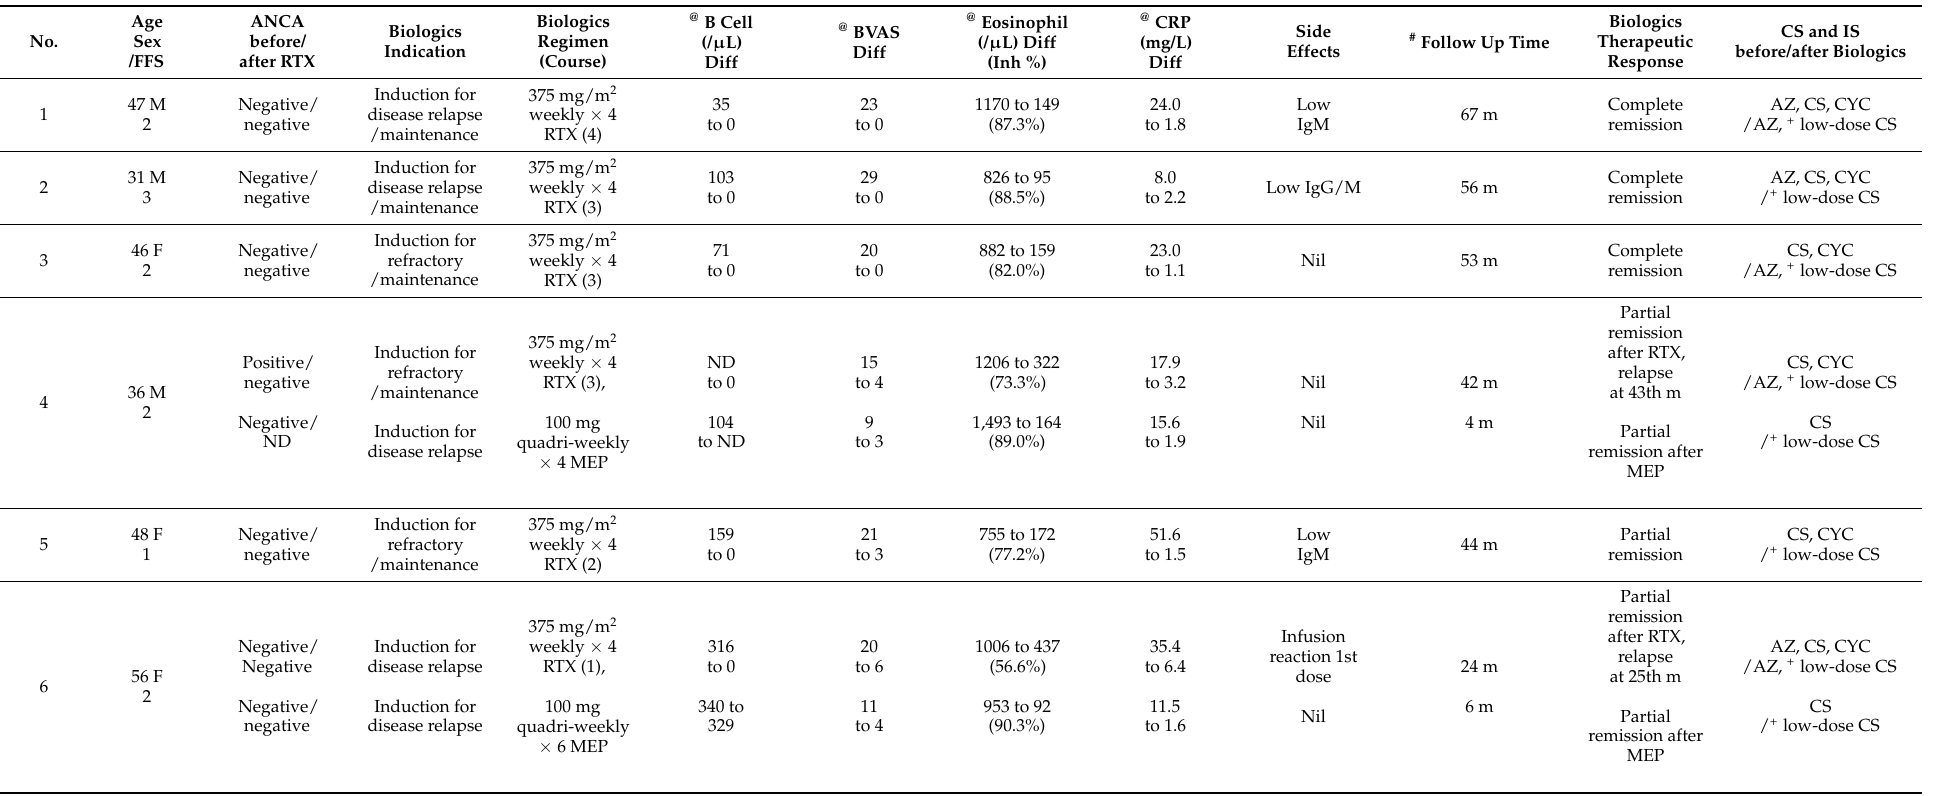
Table 3. Clinical, laboratory, medication, response data and RTX indication/regimen in six EGPA myocarditis